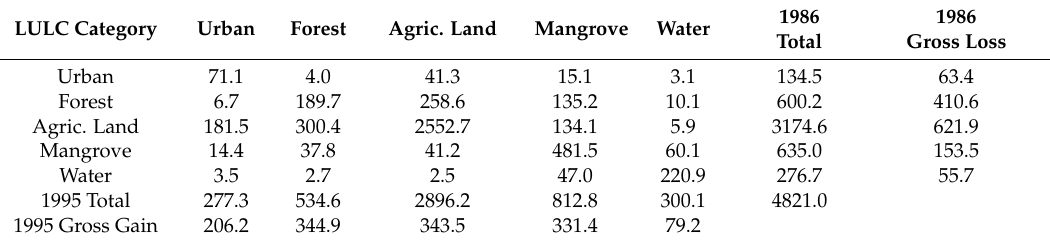
Table 6. Land-cover transition matrix of Greater Port Harcourt watershed area, 1986 to 1995. LULC Category